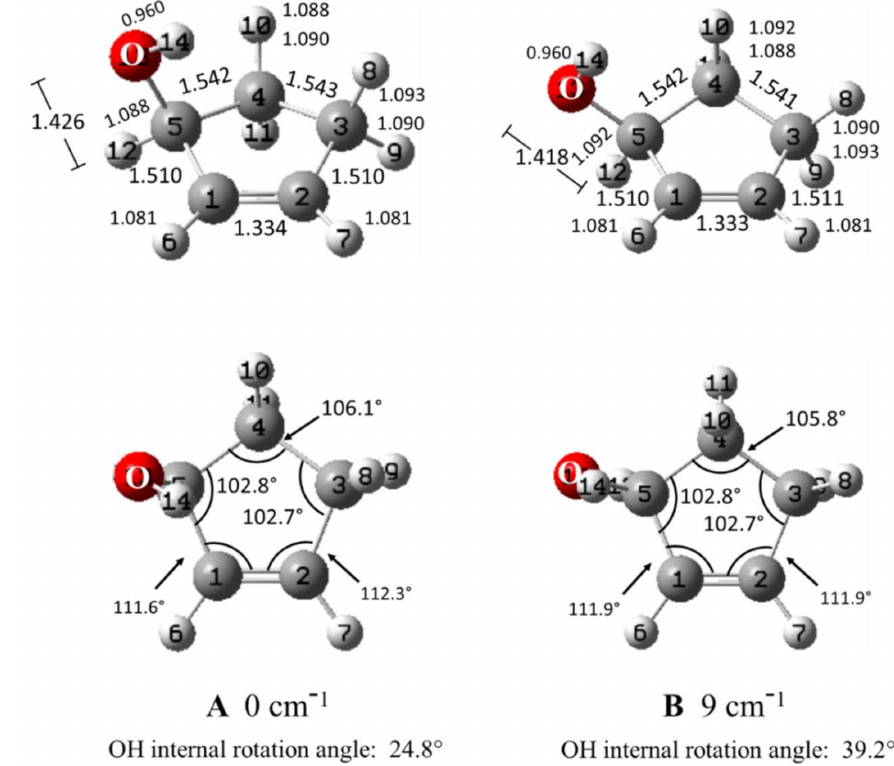
Table 2. Calculated H- π (C=C) bonding distances in cyclic molecules.